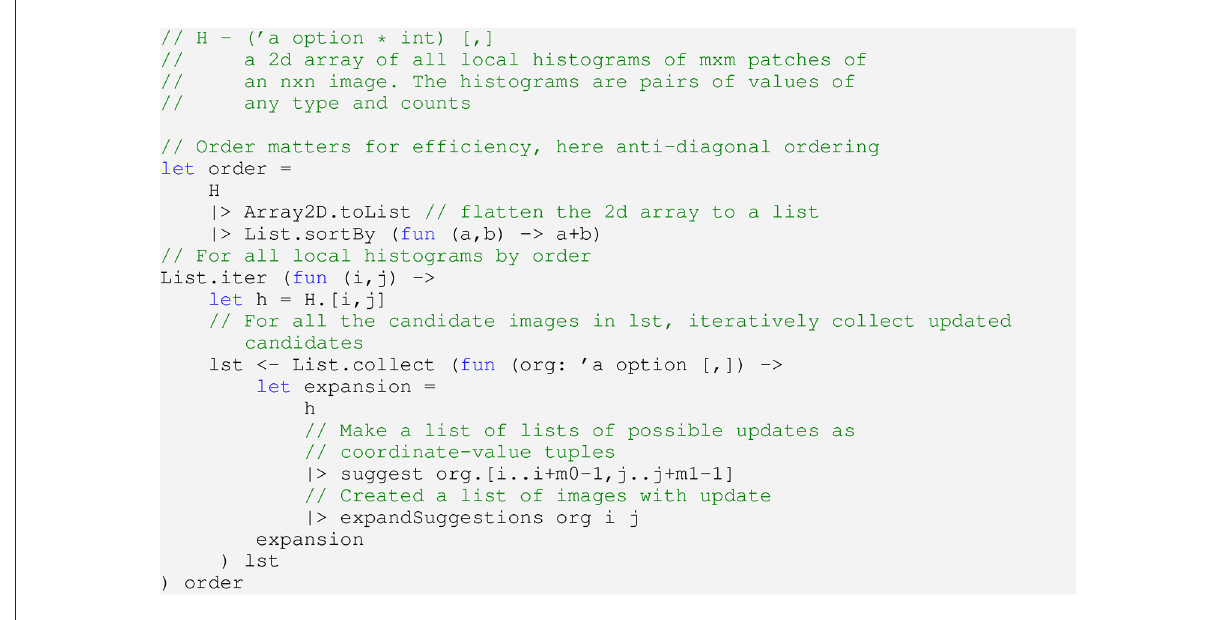
FIGURE4 An F# sifting